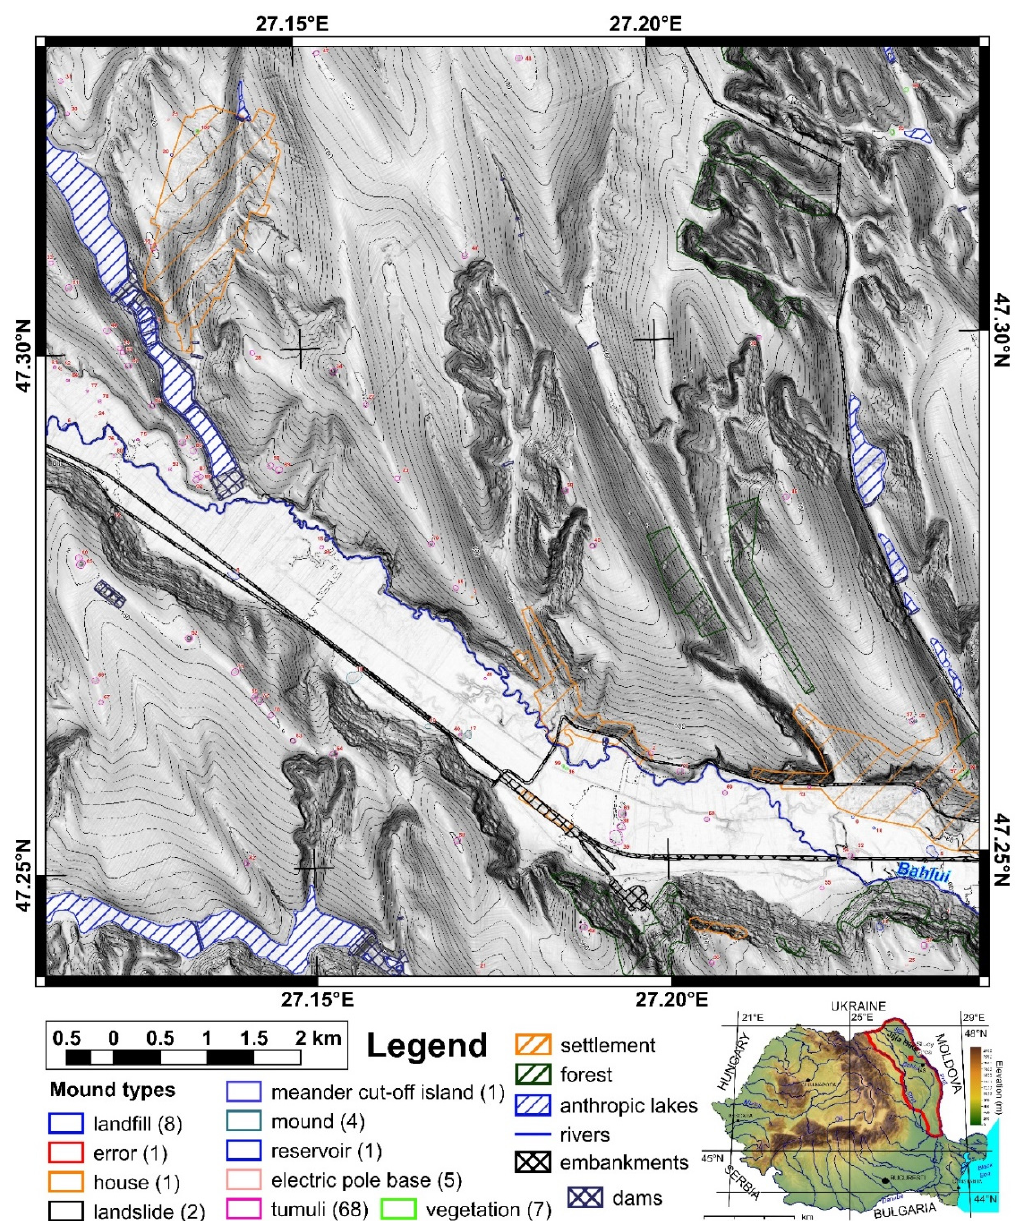
Figure 1. The geographic position of the northern study area and the location of the delineated mounds. (a high-resolution version can be found at https://doi.org/10.6084/m9.figshare.11798517.v2)